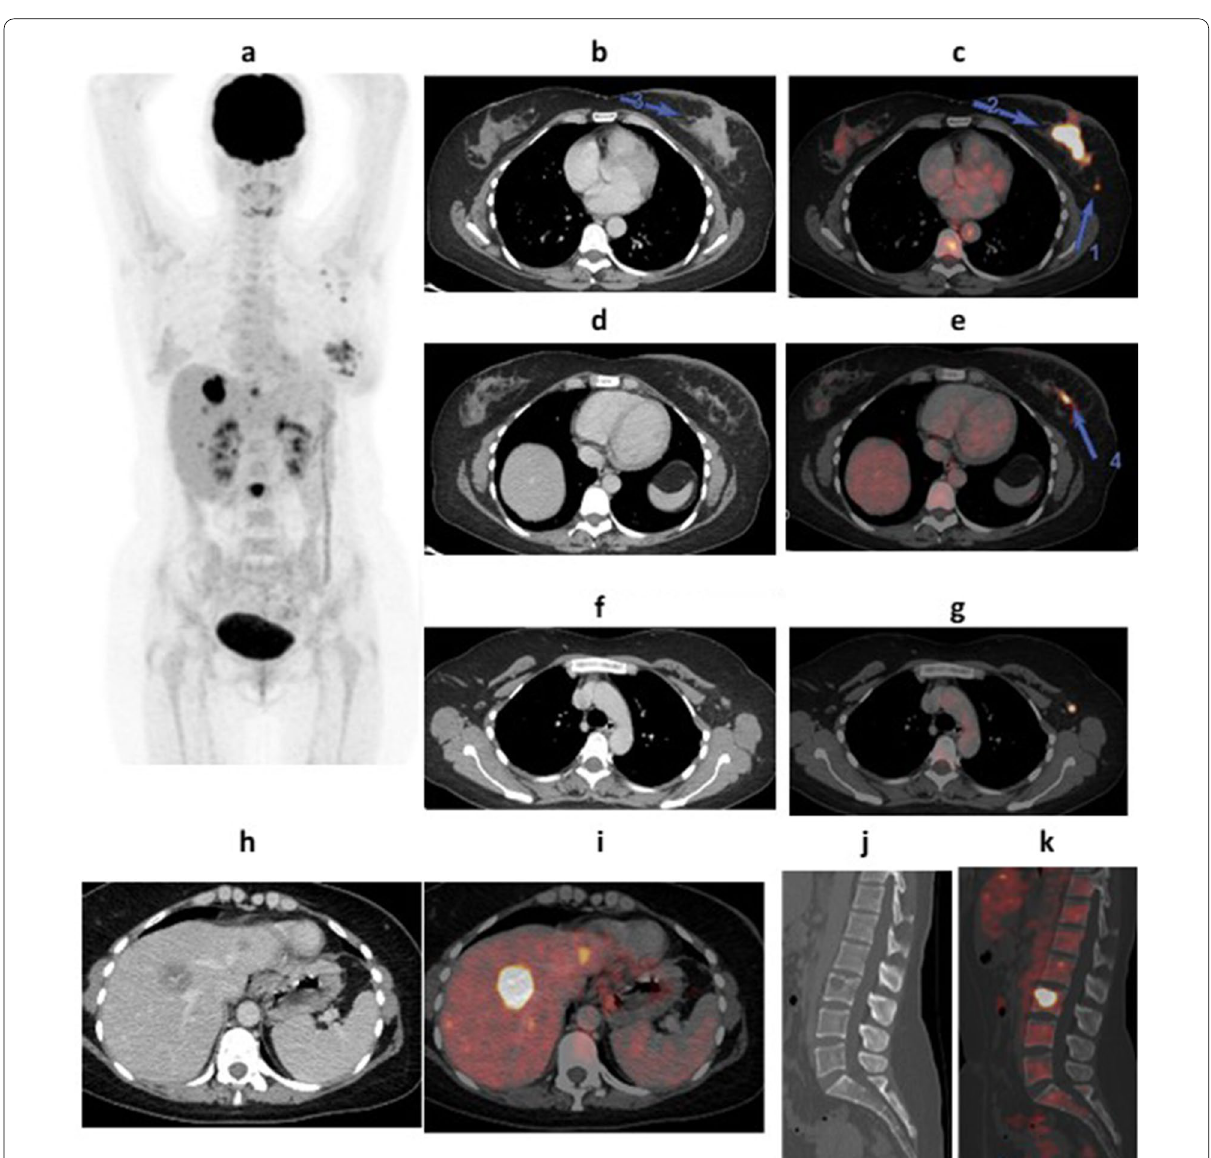
Fig. 5 A 37-year-old female patient arrived with newly diagnosed left breast cancer (IDC grade II). a A PET MIP picture of the entire body indicated active left breast, axillary, hepatic, and osseous lesions. b , c , d , e Axial CECT and fused PET/CT images revealed large ill-defined mildly enhancing speculated metabolically active left breast retroareolar soft tissue mass focally infiltrating the overlying nipple with retraction, measuring about 29 39 59 mm and achieving up to 7.9 SUVmax with other adjacent small metabolically active parenchymal lesions at lower outer quadrant, in × × fused PET/CT images, measuring up to 10 15 mm and achieving up to 6.6 SUVmax, not appreciated in CT images alone. f , g Axial CECT and fused × PET/CT images revealed few variable-sized left axillary lymph nodes, measuring up to 11 21 mm and achieving up to 6.3 SUVmax. h , i Axial CECT × and fused PET/CT images revealed bilobar hypodense metabolically active hepatic focal lesions, the largest and most active of them is seen at subsegment IVa, measuring about 29 31 39 mm and achieving 15.2 SUVmax. j , k Axial CECT and fused PET/CT images revealed hypermetabolic × × lytic osseous lesion at LV3 body, achieving 12